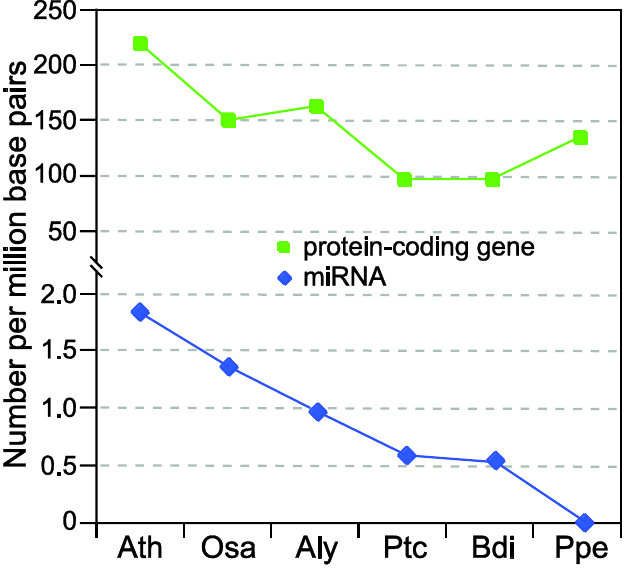
Figure 1. Comparison of the density of protein-coding and MIR genes in six plant lineages. Vertical axis indicates the density of protein-coding and MIR genes per million genomic base pairs. The six plants are Ath ( Arabidopsis thaliana ), Osa ( Oryza sativa ), Aly ( Arabidopsis lyrata ), Ptc ( Populus trichocarpa ), Bdi ( Brachypodium distachyon ) and Ppe ( Prunus persica ). The numbers of protein-coding genes are obtained from TAIR10 (Ath), RGAP6.1 (Osa) [12] and Phytozome7.0 (Aly, Ptc, Bdi and Ppe) [13] while all the numbers of MIR genes are from miRBase17